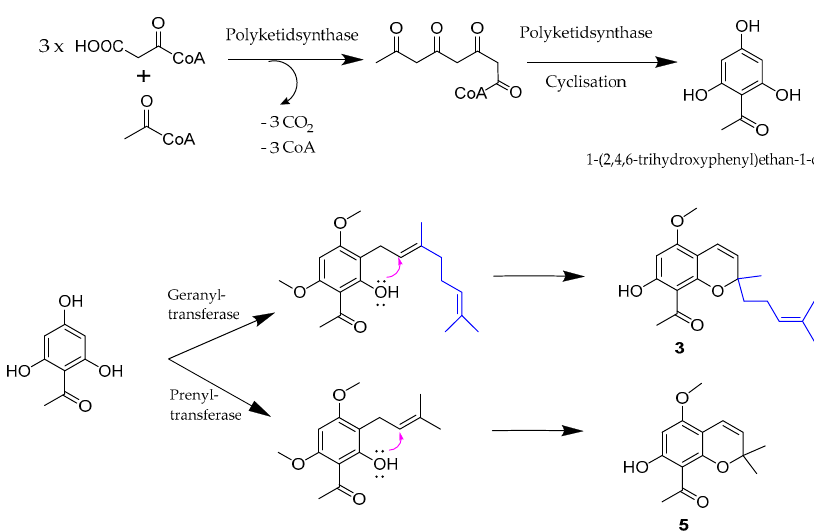
Figure 4. Proposed biosynthesis of chromenes 3 and 5 .